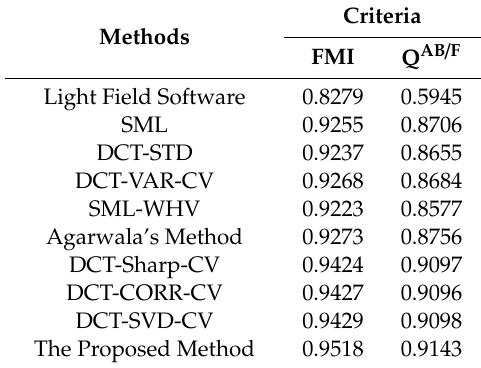
Figure 16. Comparison of ‘Flower’ image results: ( a ) Light Field Software, ( b ) SML, ( c ) DCT-STD, ( d ) DCT-VAR-CV, ( e ) SML-WHV, ( f ) Agarwala’s method, ( g ) DCT-Sharp-CV, ( h ) DCT-CORR-CV, ( i ) DCT-SVD-CV, ( j ) The Proposed Method. Table 5. Objective evaluation of the image results (non-reference fusion metrics) for ‘Flower’ image.